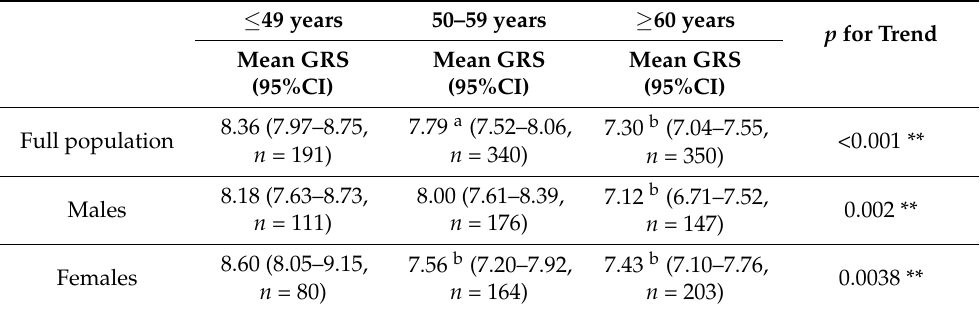
Table 3. The average value of GRS in the age categories of onset for T2DM and the results of p for trend analyses in the T2DM case population.